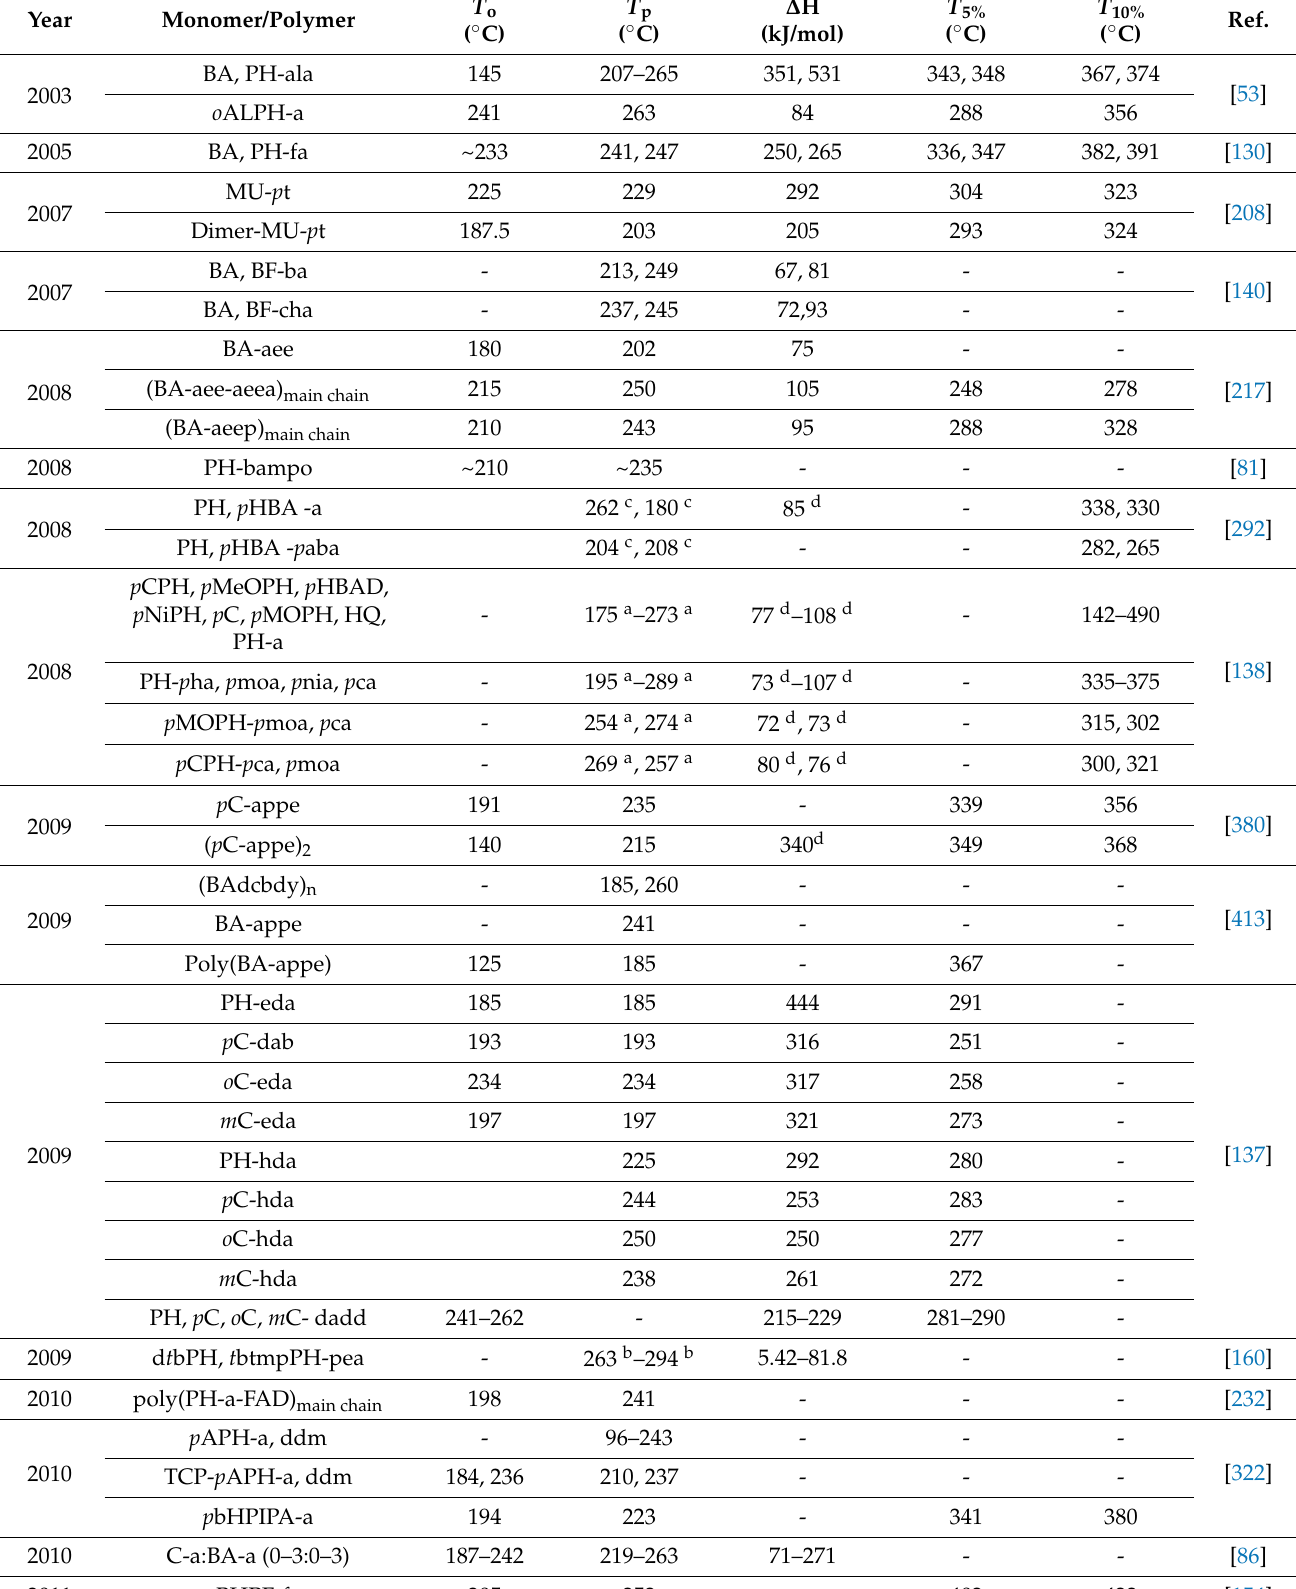
Table A2. DSC characteristics of representative benzoxazine